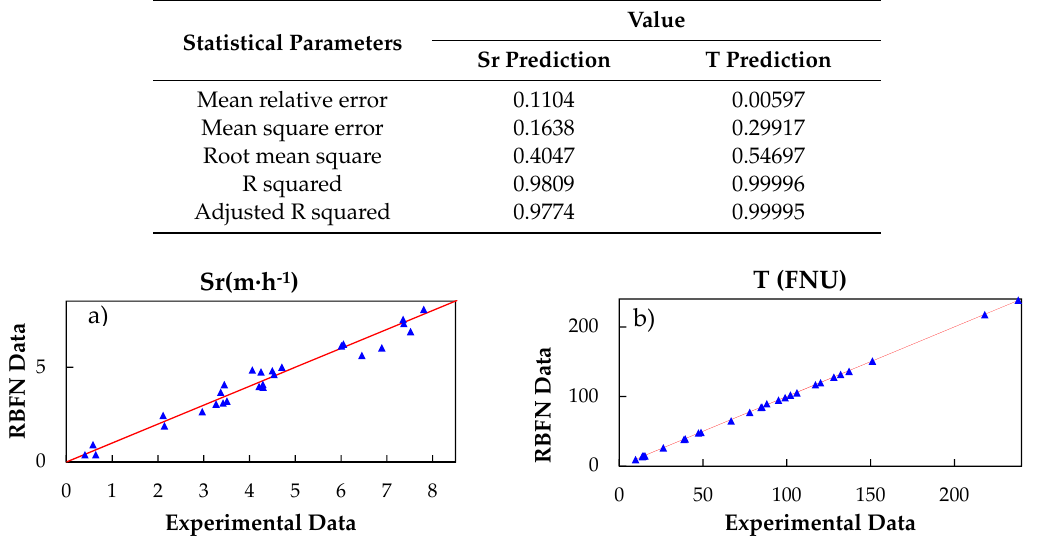
Table 6. Statistical parameters resulting from the calibration of the Radial Basis Function Network (RBFN) model.